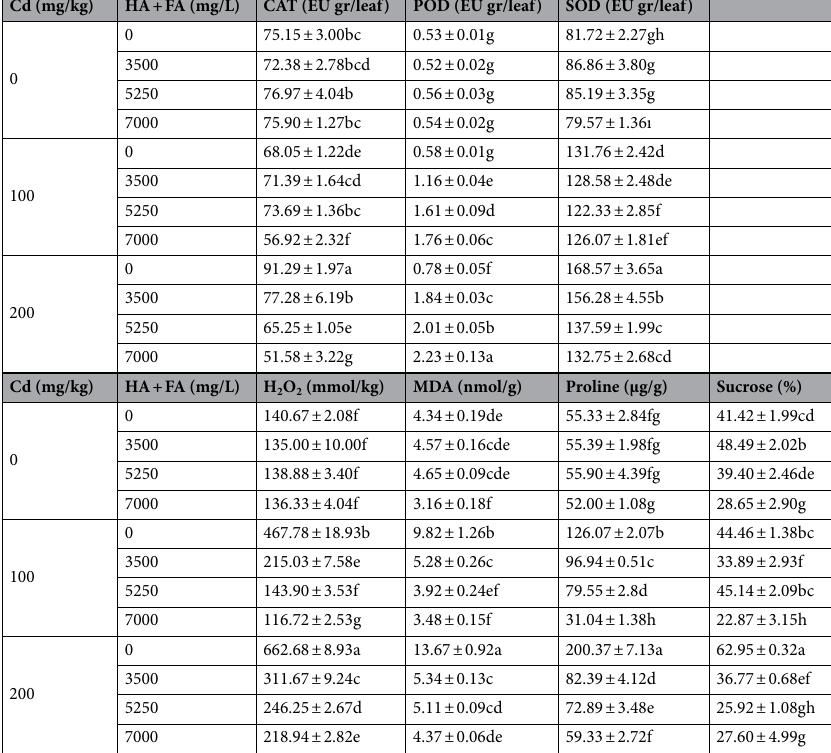
Table 3. Effect of cadmium and HA applications on CAT, POD, SOD, H 2 O 2 , MDA, proline and sucrose activities of garden cress. The difference between the means indicated by different letters in the same column is statistically significant (Duncan multiple comparison test, P <